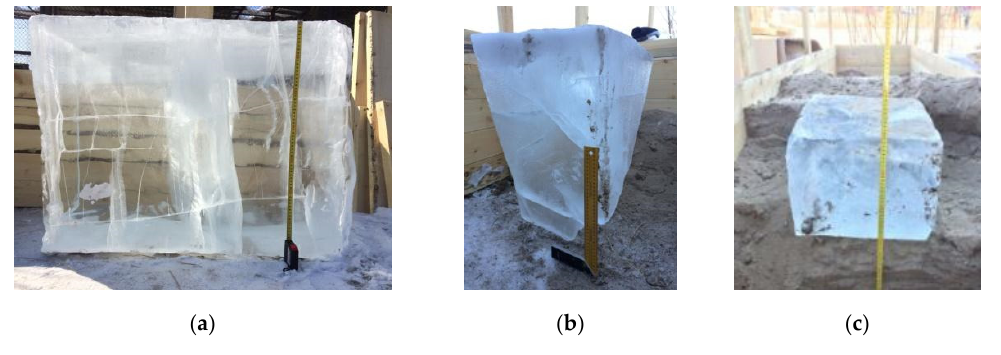
Figure 3. Models of massive ice ( a , c ) and vein ice ( b ).